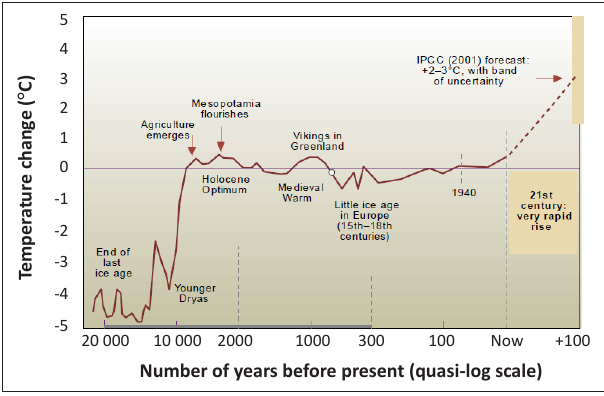
Source : Intergovernmental Panel on Climate Change, 2001, ‘Climate Change 2001: The scientific basis’, Contribution of Working Group I to the Third assessment report of the Intergovernmental Panel on Climate Change , Cambridge, Cambridge University Press FIGURE 4: Earth’s surface temperature variation curve over the past 20 000 FIGURE 4: Earth’s surface temperature variation curve over the past 20 000 years.